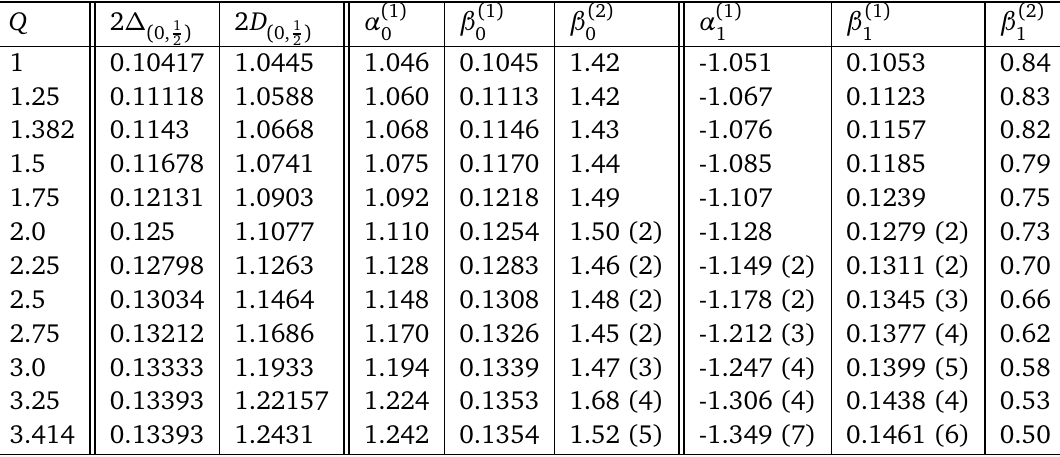
Table B.1: Fit to the form (148) of P when the error exceeds one unit of the last printed